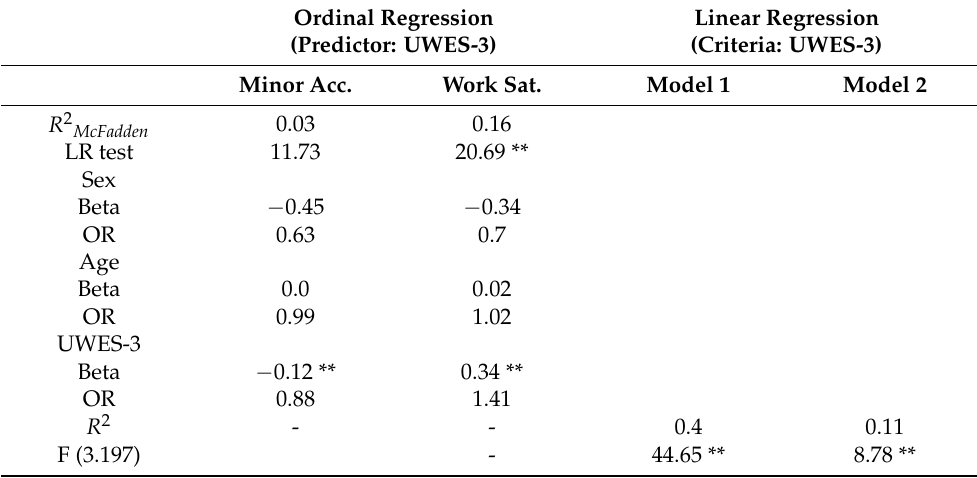
Table 3. Results of ordinal (predictor: UWES-3) and linear (criterion: UWES-3)